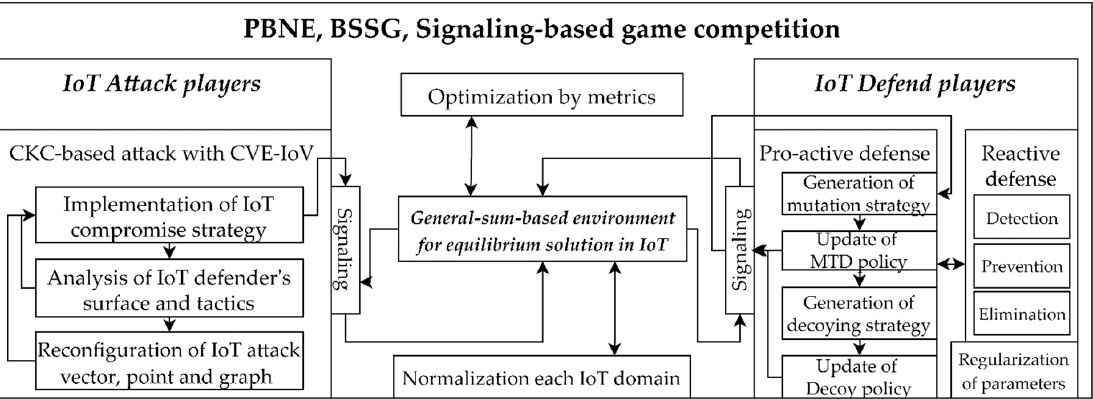
Figure 2. Detailed sub-overview of the general-sum-based attack–defense competition with PBNE, SSG, and signaling.